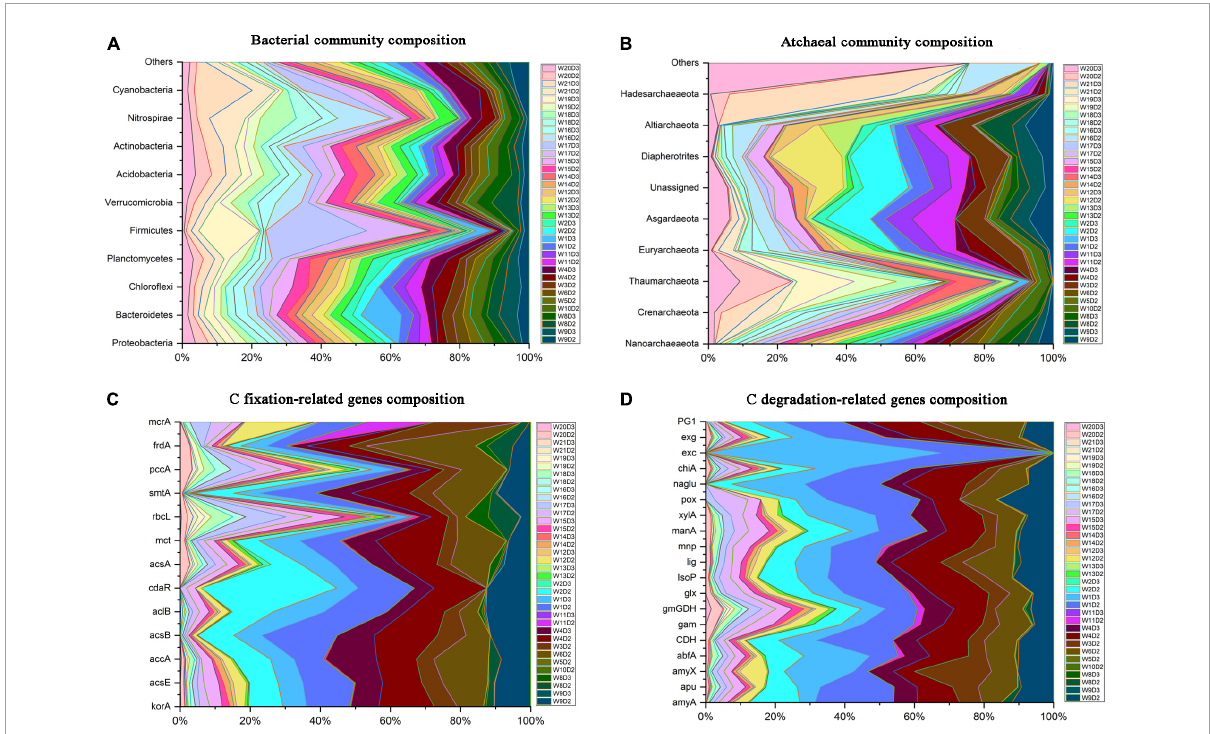
FIGURE2 Composition and spatial distribution of microbial community and carbon-functional genes. Top bacterial phyla (A) ; all archaeal phyla (B) ; carbon fixation-related genes (C) ; carbon degradation-related genes (D)